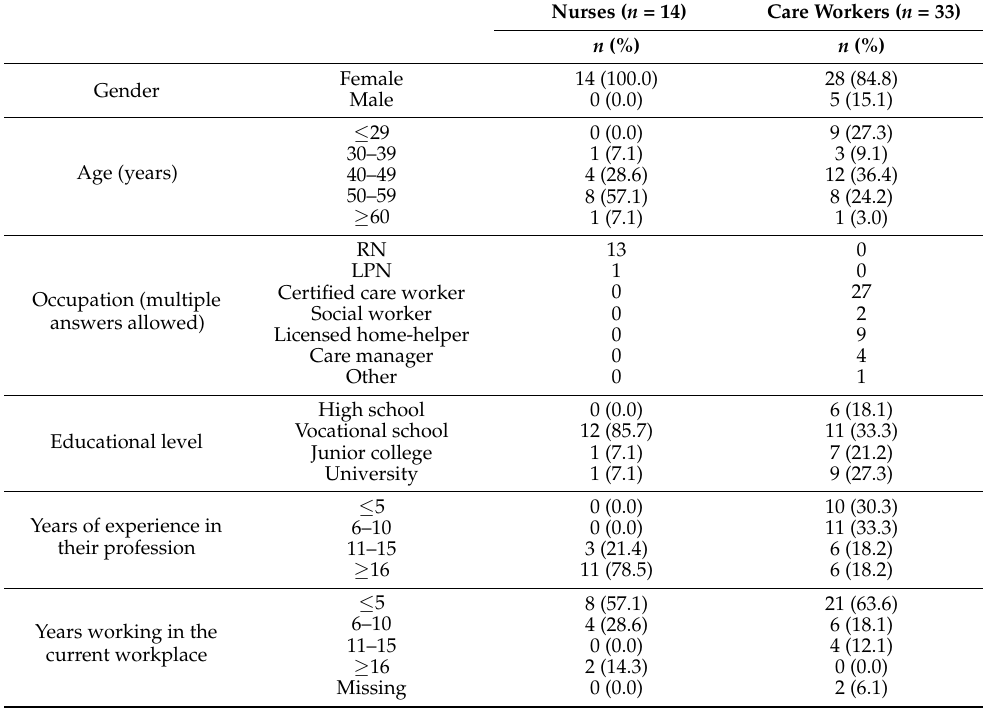
Table 2. Demographic data ( n =